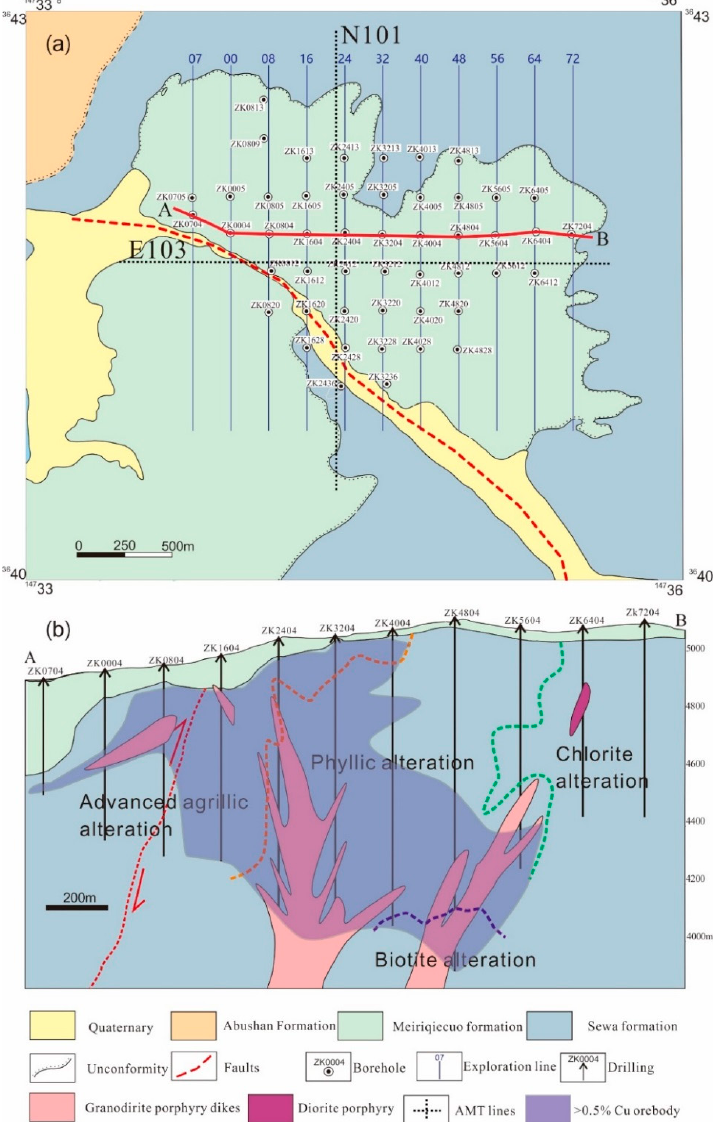
Figure 2. Ground surface and cross-section map of the Tiegelongnan porphyry Cu (Au) deposit.